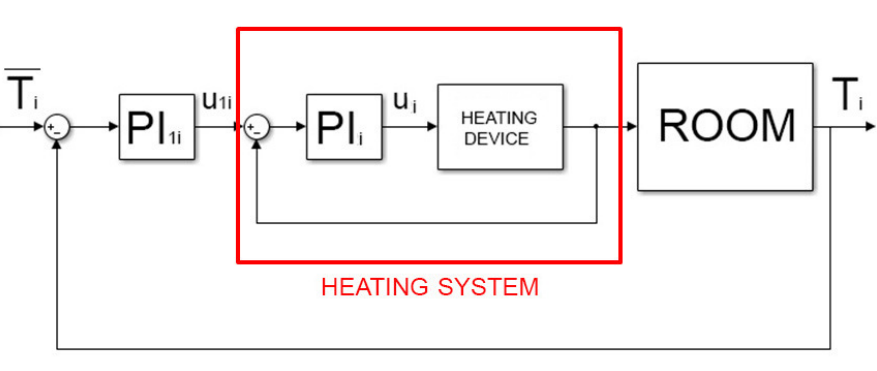
Figure 1. The control scheme for the temperature of the i th